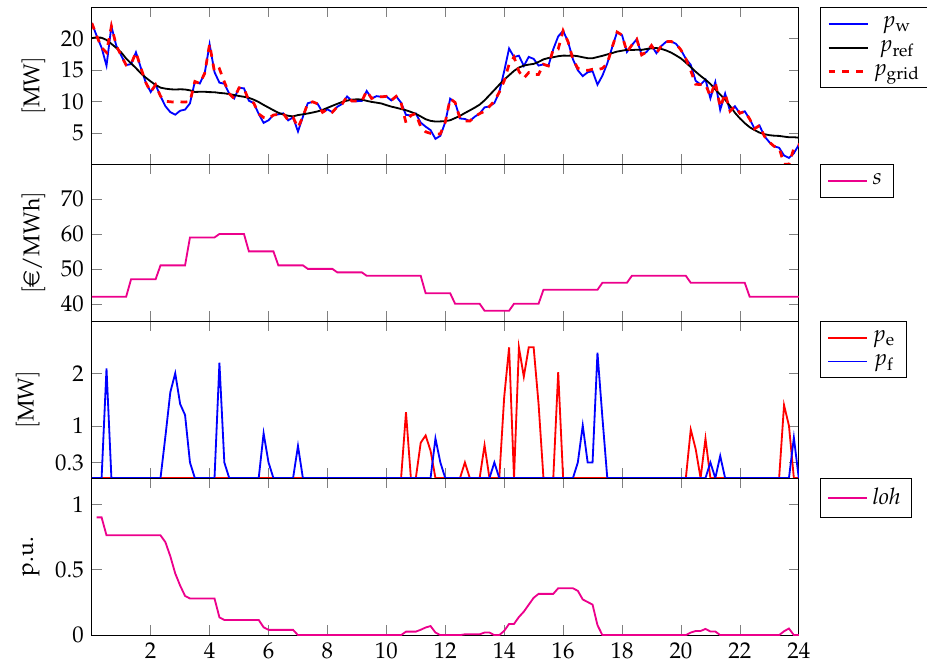
Figure 6. Different profiles related to the reference period from 14:40 of 18 February 2017 to the same hour of 19 February 2017, for highlighting the impact of c fee . First graph: power by wind N generation (blue line), power reference that has to be delivered to the grid (black line) and actual power delivered (dashed red line); Second graph: spot market prices s (source: “Gestore dei Mercati Energetici s.p.a.—www.mercatoelettrico.org (accessed on 1 July 2022)”); Third graph: power of the electrolyzer (red line) and power of the fuel cell (blue line); Fourth graph: LoH.